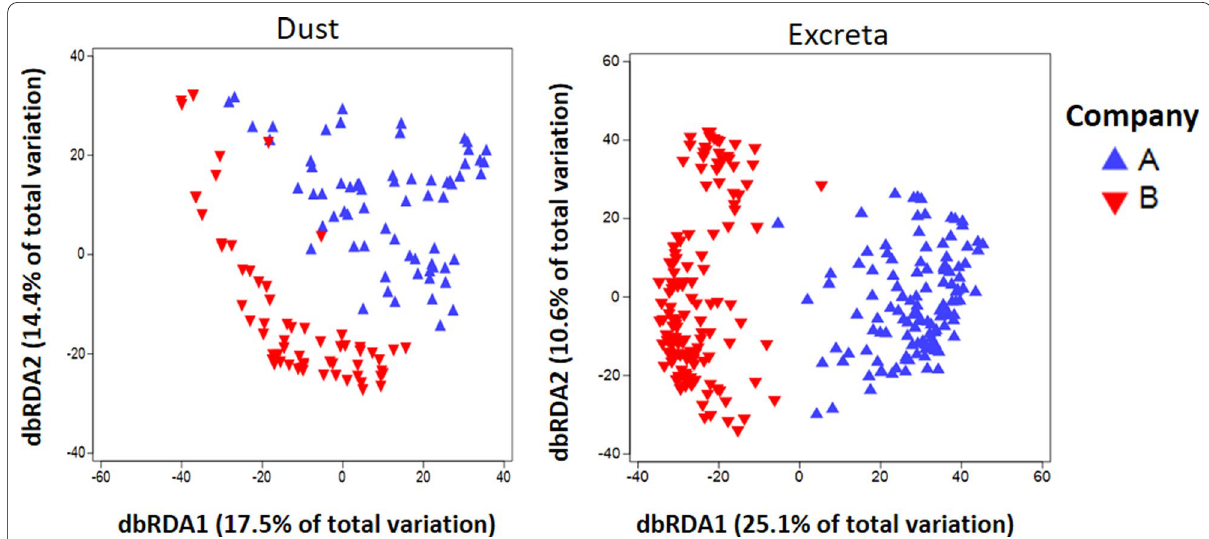
Fig. 3 Redundancy analysis showing dissimilarity in the bacterial community structure between companies stratified by sample